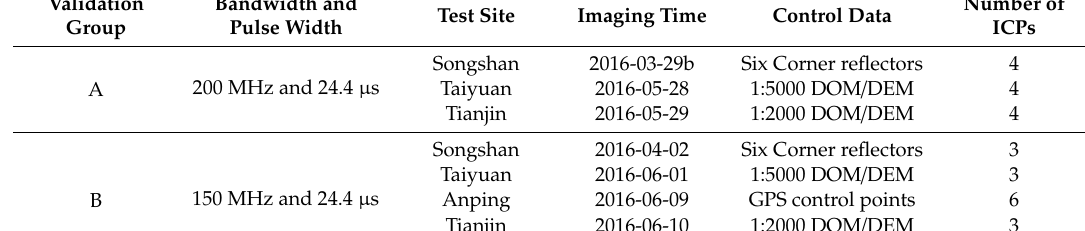
Table 5. Image data used in Validation Groups A and B.